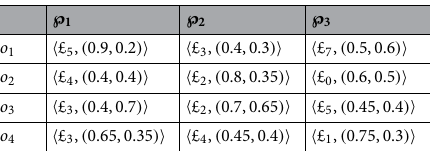
Table 2. q-rung orthopair linguistic decision matrix provided by d 2 .